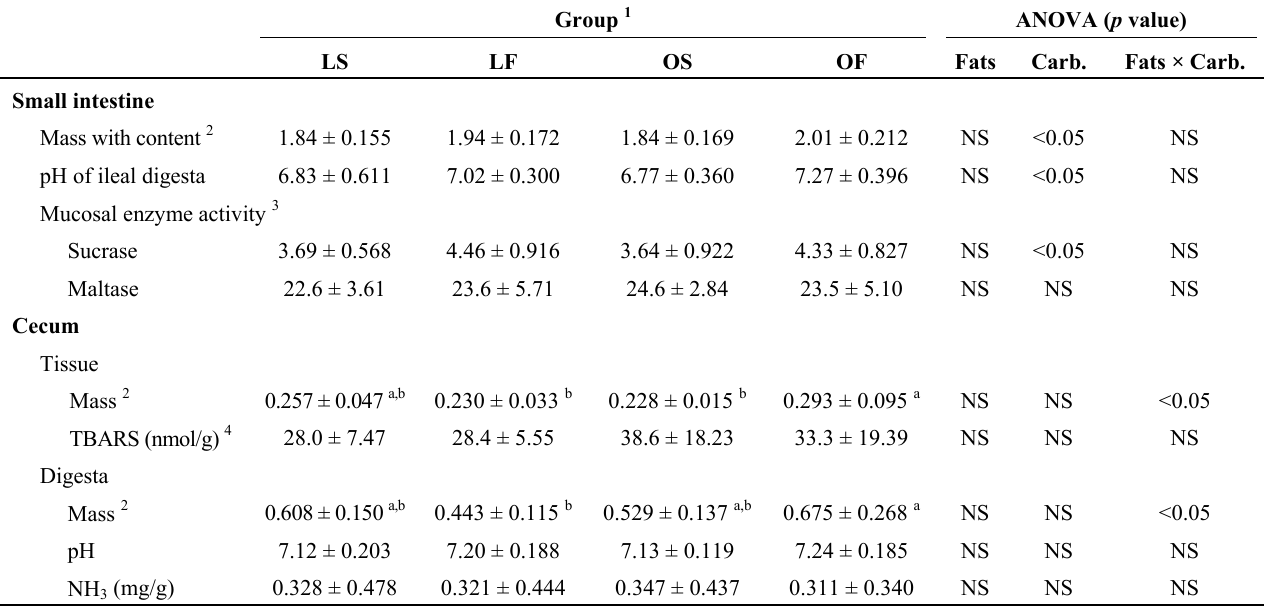
Table 2. Markers of the gut function of rats fed high-fat diets differing according to the types of fats and carbohydrates. Group 1 ANOVA ( p value) LS LF OS OF Fats Carb. Fats ×